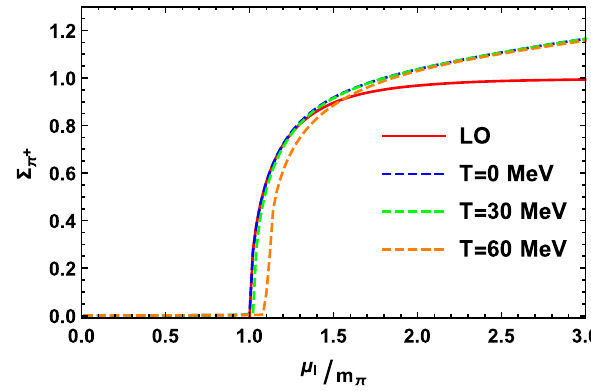
Fig. 5 Normalized pion condensate deviation, Σ π + , as a function of the normalized isospin chemical potential at vanishing and finite tem- perature to one loop. See main text for details